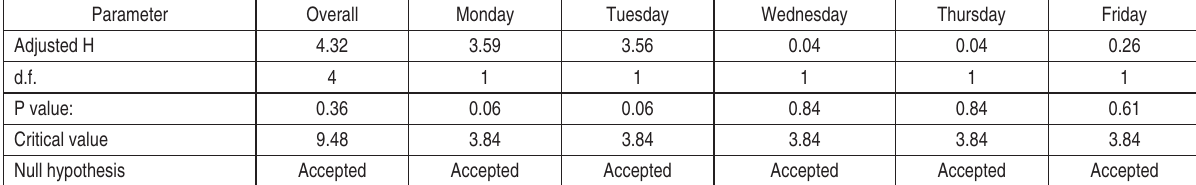
Table B7. Kruskal-Wallis test of the day-of-the-week effect for PFTS index